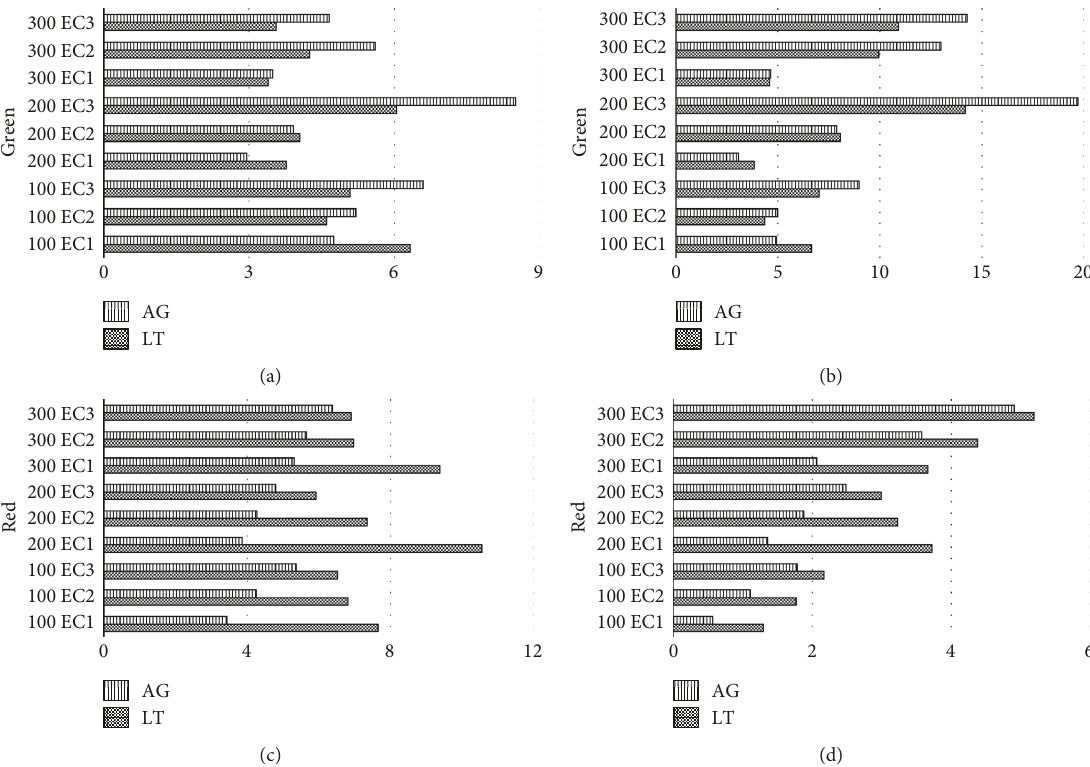
Figure 4: Comparative content of apigenin and luteolin in perilla plants after 5 weeks of cultivation under different LI and EC treatments. (a) AG vs LTcontent per leaf dry weight ( µ g · g − 1 ) in green; (b) AG vs LTcontent per plant (mg · plant − 1 ) in green; (c) AG vs LTcontent per leaf dry weight ( µ g · g − 1 ) in red; (d) AG vs LT content per plant (mg · plant − 1 ) in